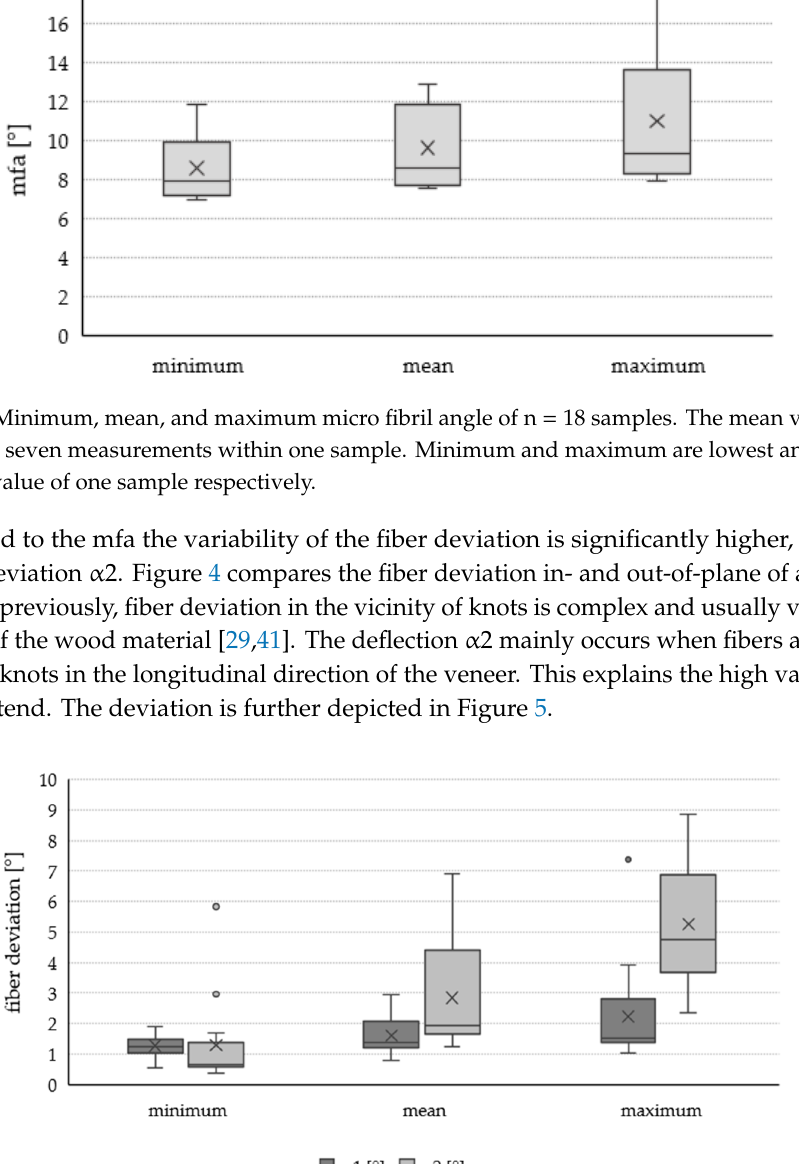
Figure 5. In-plane fiber deviation in the vicinity of a knot. Axis 1 represents the longitudinal direction of the veneer and axis 2 either the tangential or the radial direction respectively. Based on findings in the literature [31,42], it was expected that the deviation out-of-plane α 1 also exhibits high variability due to knots. However, the observed variability (see Figure 4) is rather low compared to the in-plane deviation α 2. As reported by Foley [42] (p. 463), α 1 normalizes faster compared to α 2 which influences a much bigger area around the knot. Therefore, the measuring area of the out-of-plane deviation is much more sensitive. Placing the measuring area too far away from the knot could lead to an underestimation of α 1 and furthermore report a too low bulk α 1 for the whole sample. According to Stahl [43] the heaviest affected area is approximately on knot radius around the visual border of the knot. 3.3. Fiber Deviation and Strength The correlation between the different angles investigated in this study and the respective strength of the sample is depicted in Table 2. In general, all angles correlate negatively with strength. This was expected as strength parallel to the fiber is approximately ten times higher than perpendicular [5,7]. Therefore, any off-axis loading leads to a decrease in strength. Best correlation was achieved with mean β (r = − 0.846) and maximum α 2 (r = − 0.852). Correlation with mean α 2 (r = − 0.806) as well as maximum β (r = − 0.818) was also high but considerably lower. Other correlations including all minimum angles were still significant but exceedingly below 0.800.